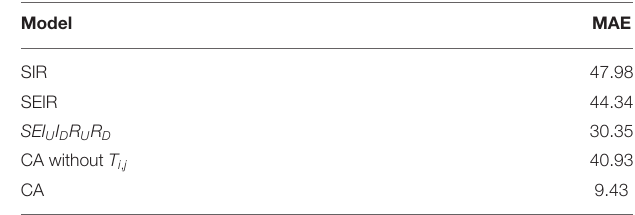
TABLE 5 | MAE of the models on the outbreak data of